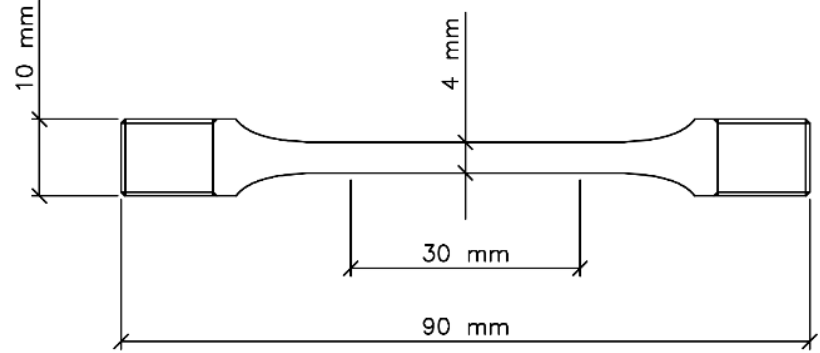
Figure 2. Scheme of the tensile specimens adopted in slow strain rate tests (SSRT).